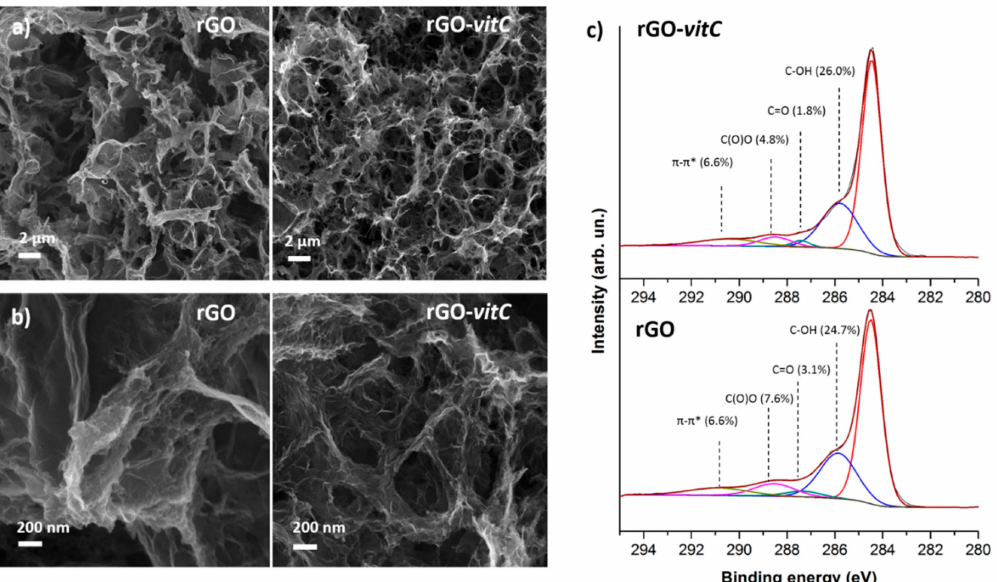
Figure 1. Morphological comparison between reduced graphene oxide (rGO) and rGO- vitC aerogels at low ( a ) and high ( b ) magnification by FESEM images; ( c ) reports the deconvolution through synthetic components of the C1s region of the photoelectron spectrum for both